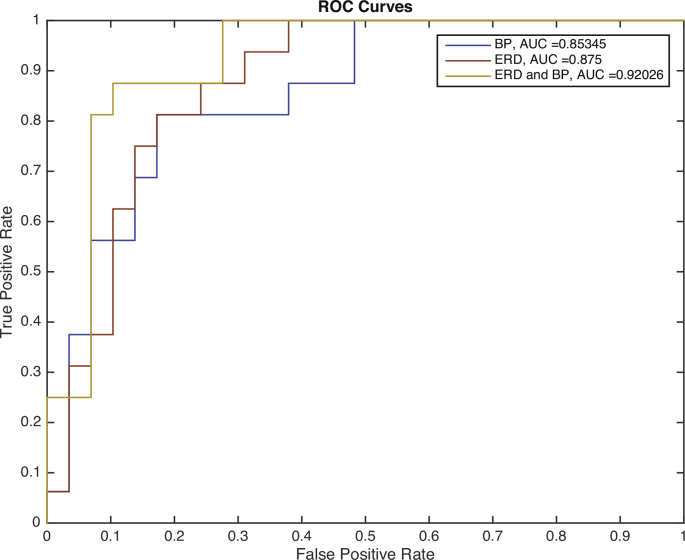
Receiver Operating Characteristics (ROC) for the use of the quantified Bereitschaftspotential (BP), Event Related Desynchronisation (ERD) and the combination of the two (ERD and BP) and their Areas Under the Curve (AUC, range 0–1). None of the AUC's differed significantly.